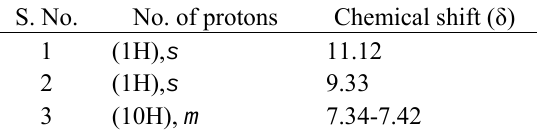
Table 3. 1 H NMR spectral data of phenytoin